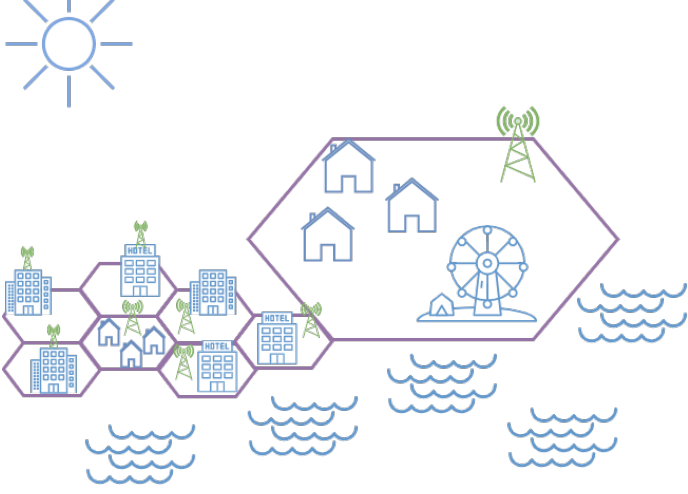
Figure 1. Urban, rural and isolated cells in a mobile phone network. Voronoi polygons are commonly used to build these cells, but those geometries are replaced by hexagons to emphasise the concept of